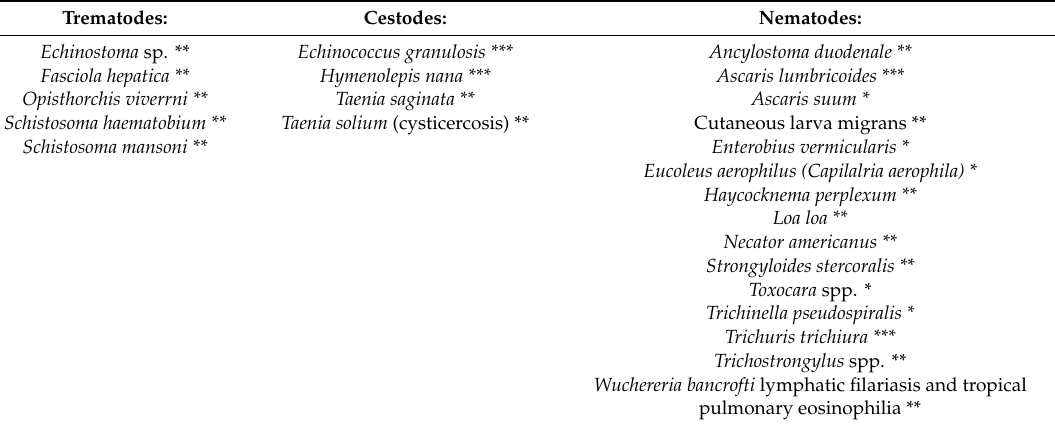
Table 1. Helminth infections diagnosed in